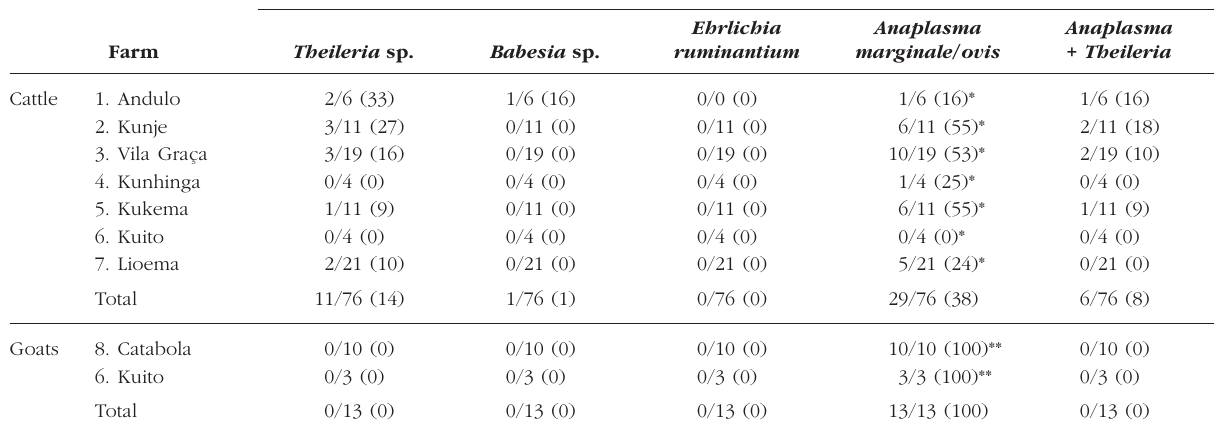
Table II. – Prevalences of detected tick-transmitted